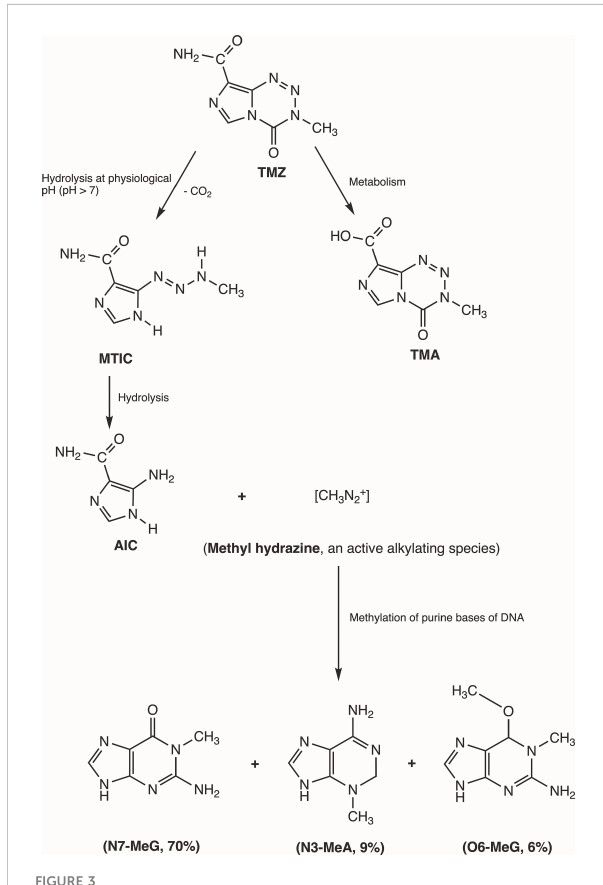
FIGURE 3 Mechanism of TMZ after oral administration. Activation of prodrug (TMZ) occurs at physiological pH (>7) after oral intake. TMZ is stable in an acidic environment (pH<7) and degrades rapidly by hydrolysis at basic pH. TMZ hydrolyzation results in MTIC via decarboxylation and further hydrolysis produces AIC and methyl hydrazine (DNA methylating species). The pH of brain tumors is alkaline compared with healthy surrounding tissues, resulting in increased activation of TMZ within the tumor environment (35). (TMZ, temozolomide (3- methyl-4-oxo-3H,4H-imidazo[4,3-d][1,2,3,5]tetrazine-8- carboxamide); TMA, temozolomide acid; MTIC, 5-(3-methyltriazen- 1-yl)-imidazole-4-carboxamide; AIC, 5-aminoimidazole-4- carboxamide; N7-MeG, methylation at N7 position of guanine; N3- MeA, methylation at N3 position of adanine; O6-MeG; methylation at O6 position of